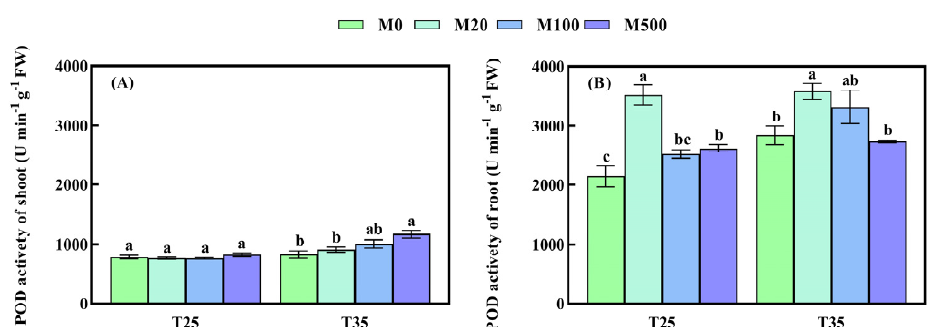
Figure 3. Effects of exogenous melatonin on the POD activity of rice seed shoots and roots under drought stress. Means ± SEs with different letters in each parameter indicate significant statistical differences (LSD, 0.05). ( A ) POD activity of shoot; ( B ) POD activity of root.